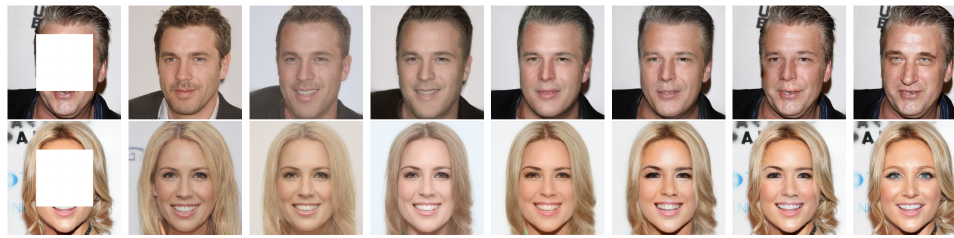
Figure 6. The images generated by the intermediate process of our method when the images are